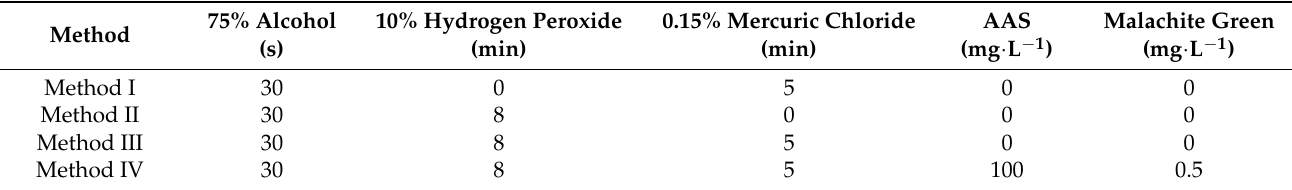
Table 1. Different sterilization combination or process of H. serrata